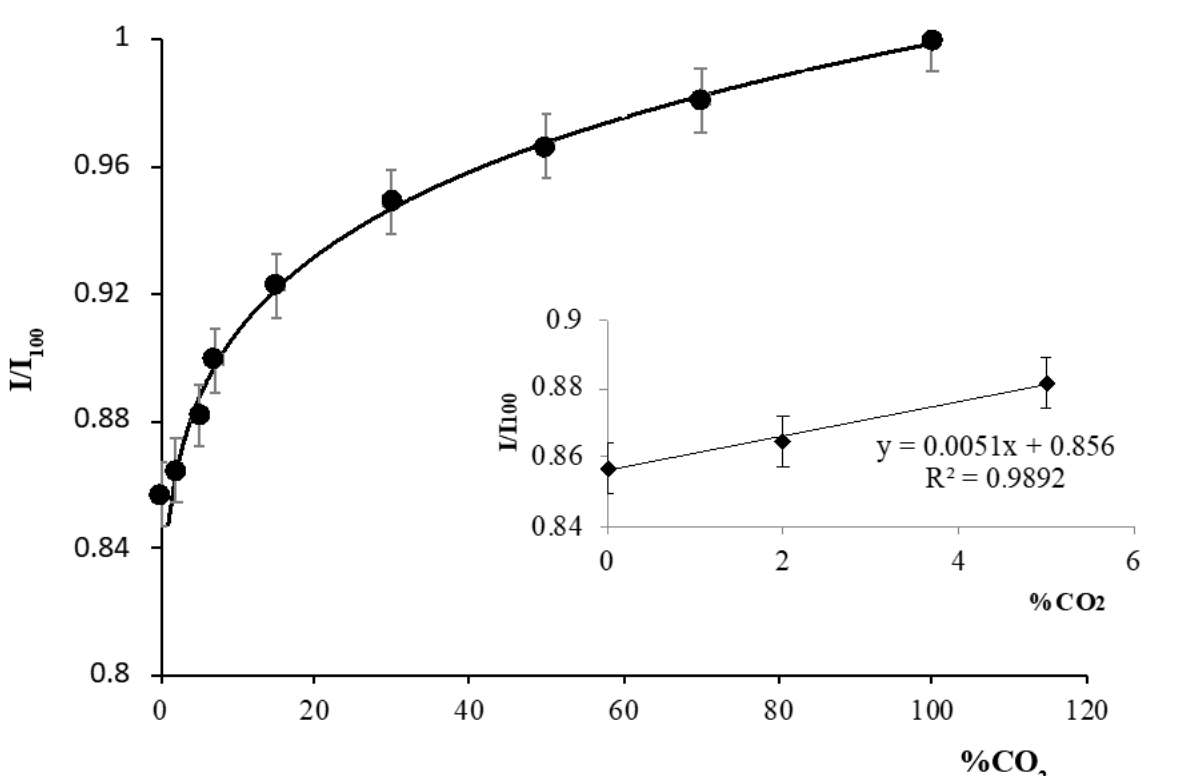
Figure 3. Sensor response to CO 2 concentration. Insert: linearization of the first three experimental raw data for LOD and LQD calculation.